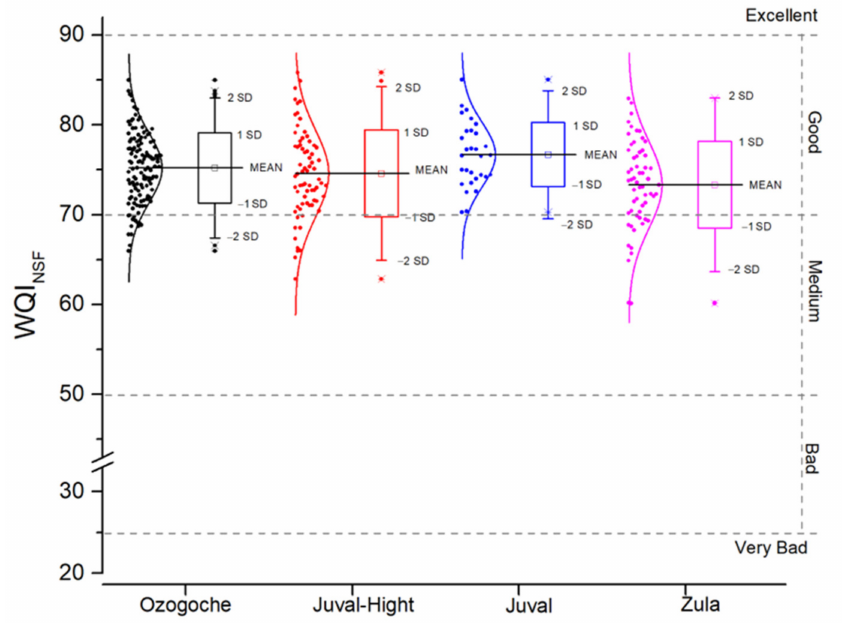
Figure 7. Boxplot showing the distribution of the WQI NSF values, the mean value (MEAN), one standard deviation (1 SD), and two standard deviations (2